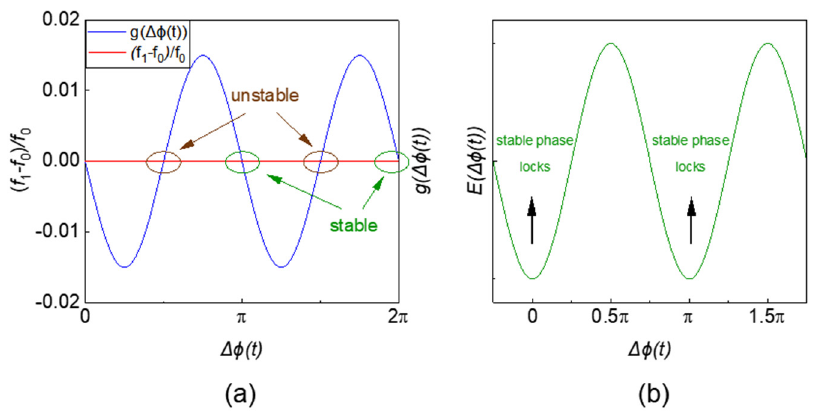
Figure 9. ( a ) Graphical solutions of the locking phase and range of SHIL; ( b ) the relationship between the system’s energy and phase difference.